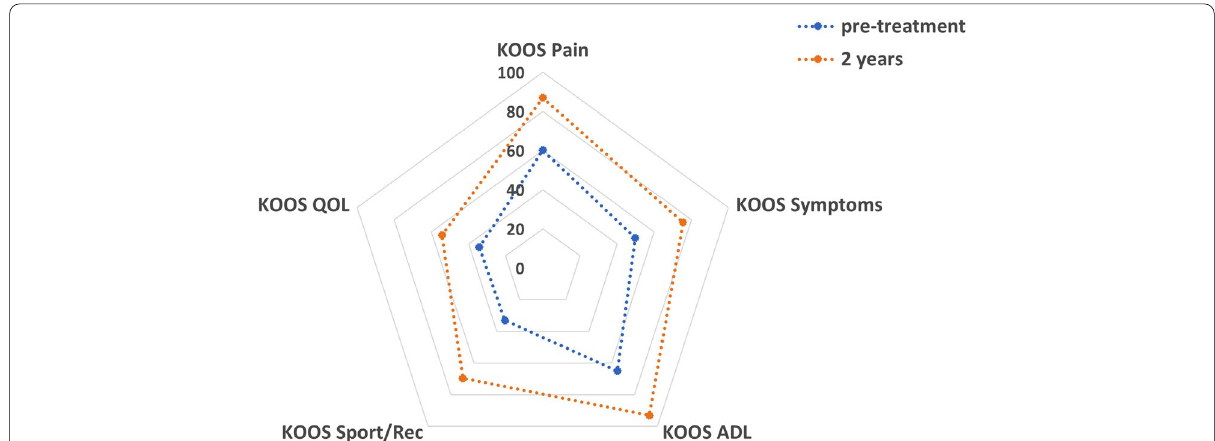
Fig. 1 Spider chart demonstrating improvements at 2-year follow-up (orange line) in all sub-sections of the KOOS in comparison to the preoperative score (blue